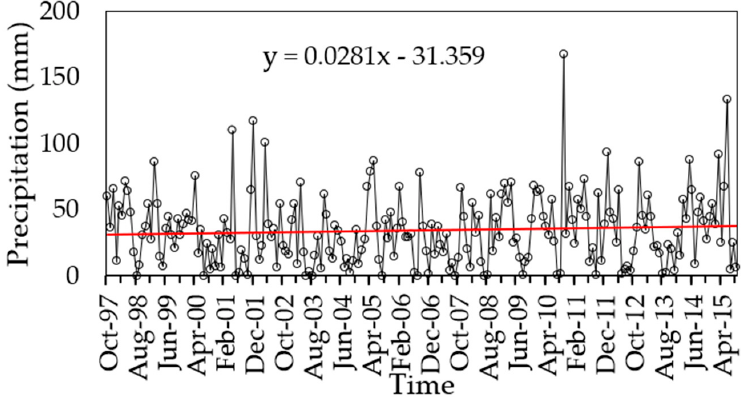
Figure 5. Time series and linear trend analyses of humidity data between 1997 and 2015. Figure 6. Time series and linear trend analyses of wind speed data between 1997 and 2015.